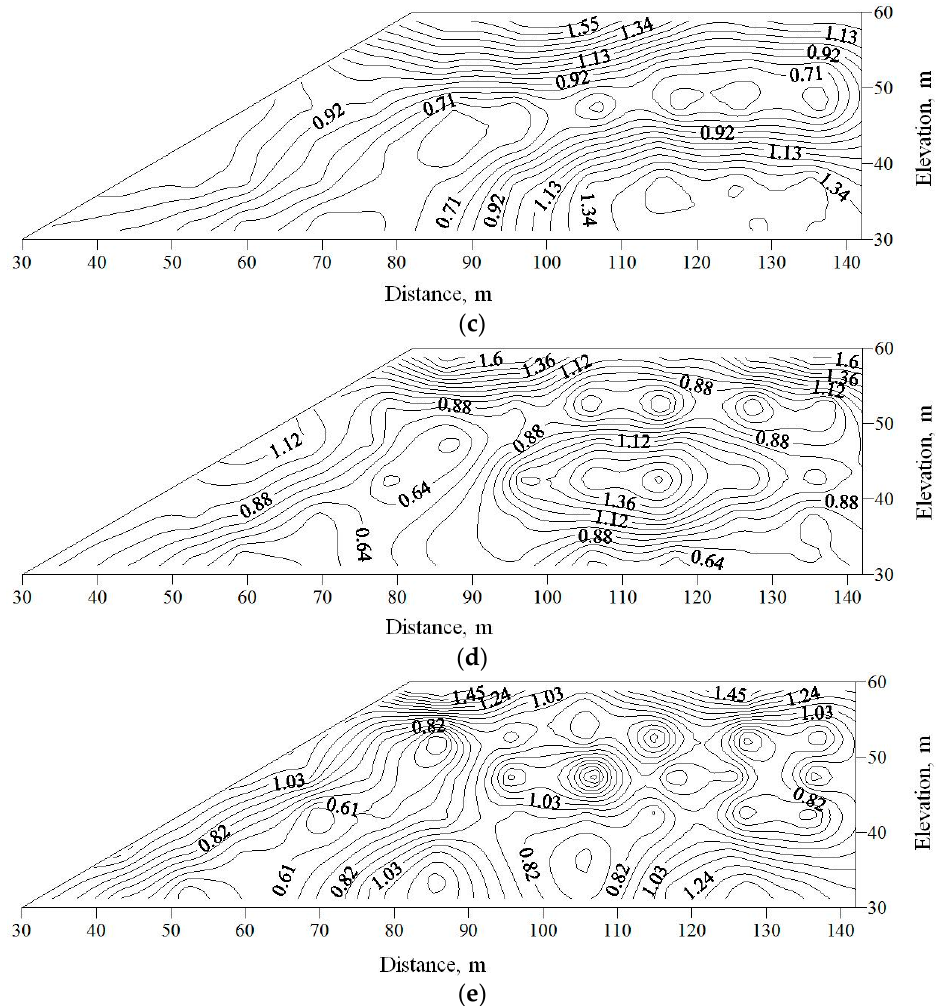
Figure 13. The distribution regularity of acceleration amplification coefficient of the slope on spatial domain (where K = 0.5); ( a ) ξ = 0.05; ( b ) ξ = 0.1; ( c ) ξ = 0.2; ( d ) ξ = 0.3; ( e ) ξ = 0.4.